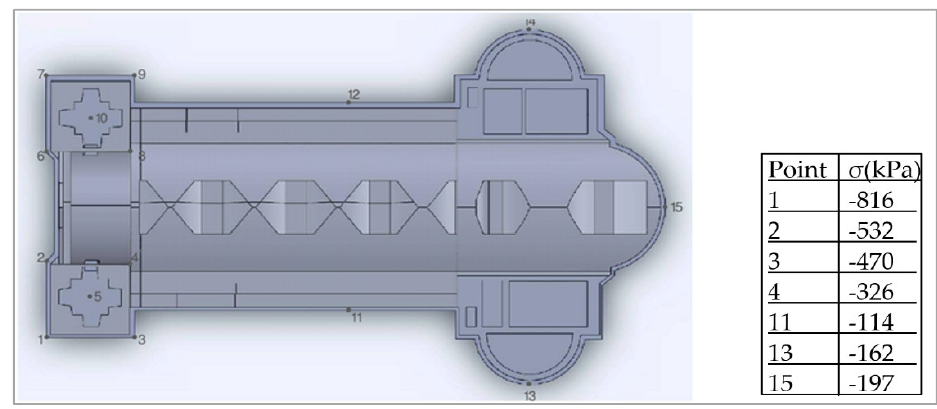
Figure 14. Characteristic points for contact stresses below the foundations of the Cathedral.